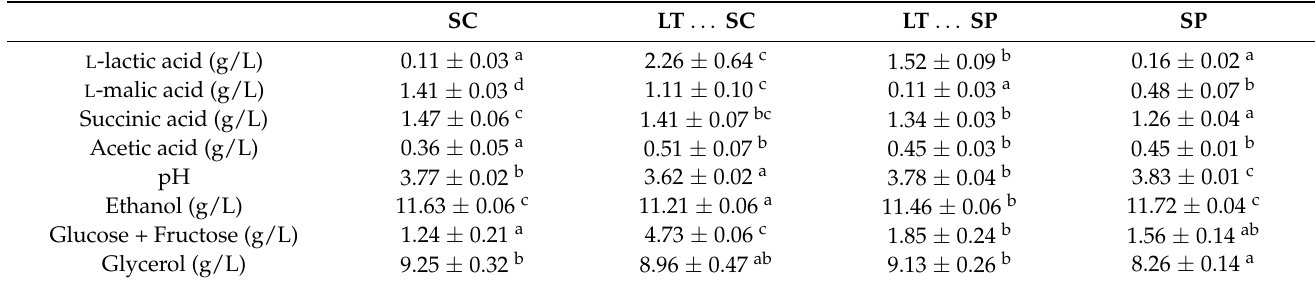
Results are mean ± SD of three replicates. Different letters indicate statistical significance between